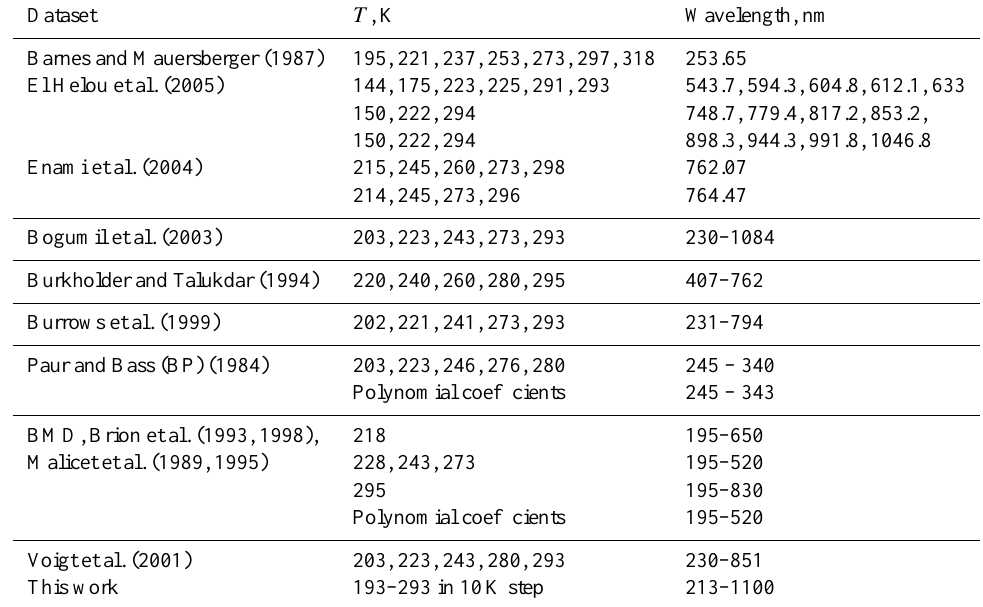
Table 1. Characteristics of the datasets on ozone absorption cross-sections.